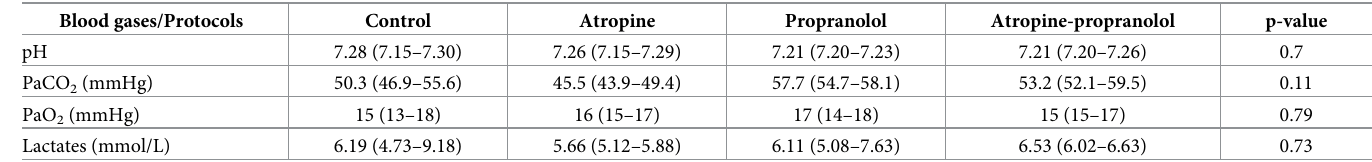
Table 2. Comparison of the concentrations of fetal arterial blood gases and lactate between protocols at the end of the three cord occlusions. Blood